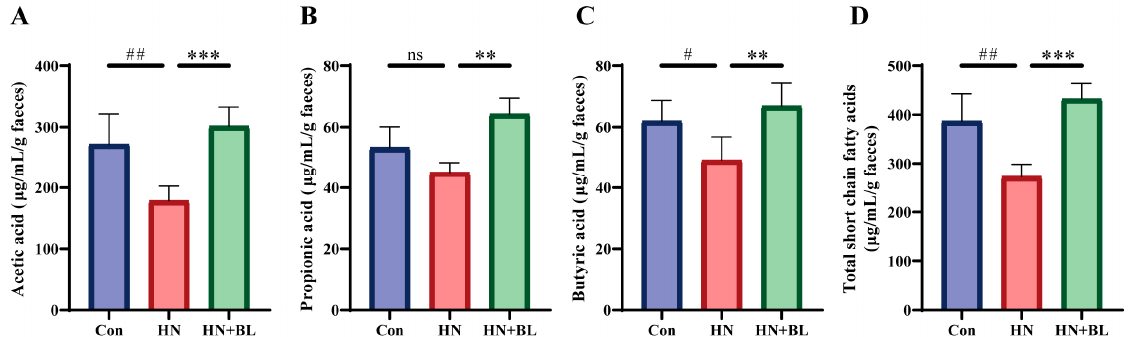
Figure 6. Effect of BL on the fecal SCFAs content in mice with HN. ( A ) Acetic acid. ( B ) Propionic acid. ( C ) Butyric acid. ( D ) Total SCFAs. Data represent mean ± SD ( n = 6). # p < 0.05, ## p < 0.01, vs. the Con group; ** p < 0.01, *** p < 0.001 vs. the HN group; ns means no significance.